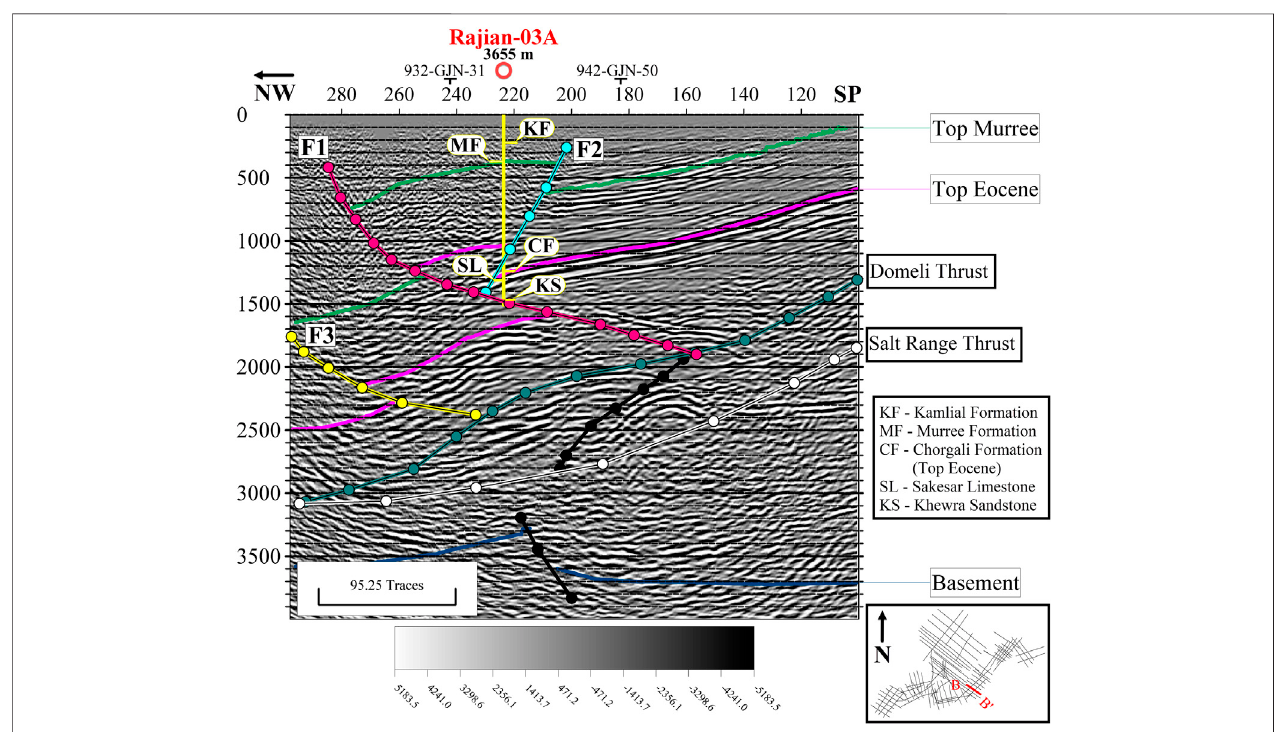
FIGURE 4 | Interpreted seismic section of line 925-GJN-10 of Rajian fi eld in zone-1 of the eastern Potwar study area. Marked horizons include top Murree (green) and top Eocene (purple) along with fore thrusts (Salt Range Thrust, Domeli thrust, and F2) and back thrust faults (F1 and F3) in different colors. Duplex based repeated thrust sheets are present in the area and Rajian-03A well has been drilled on the top sheet.